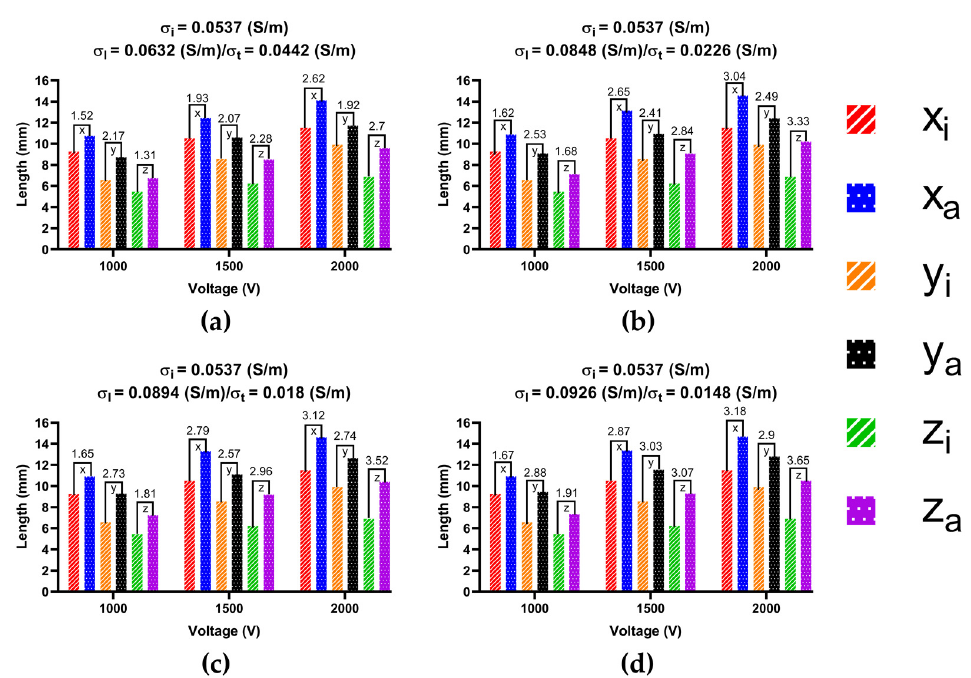
Figure 12. The statistical results of the size of the ablation isosurface under the condition of different PFA amplitudes at ablation target 2. The statistical results of the size of the ablation isosurface in myocardial electrical conductivity ( a ) group 1; ( b ) group 2; ( c ) group 3; and ( d ) group 4.